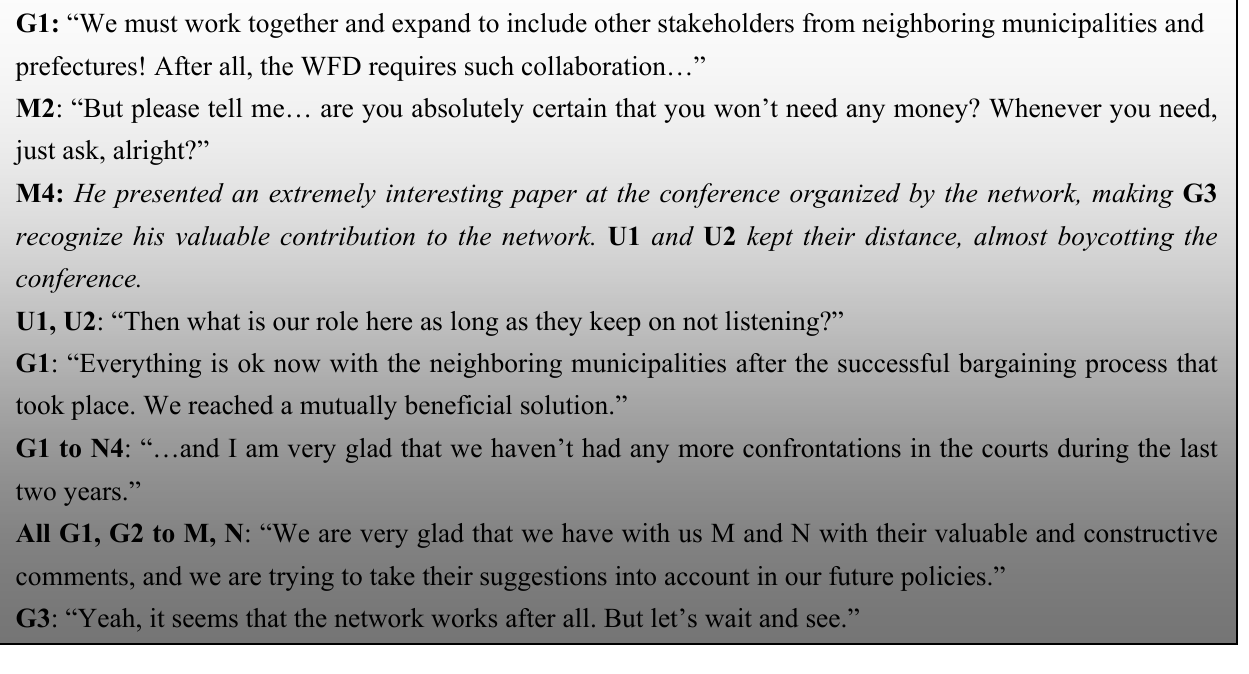
Figure 3. The astonishing experience of a changing